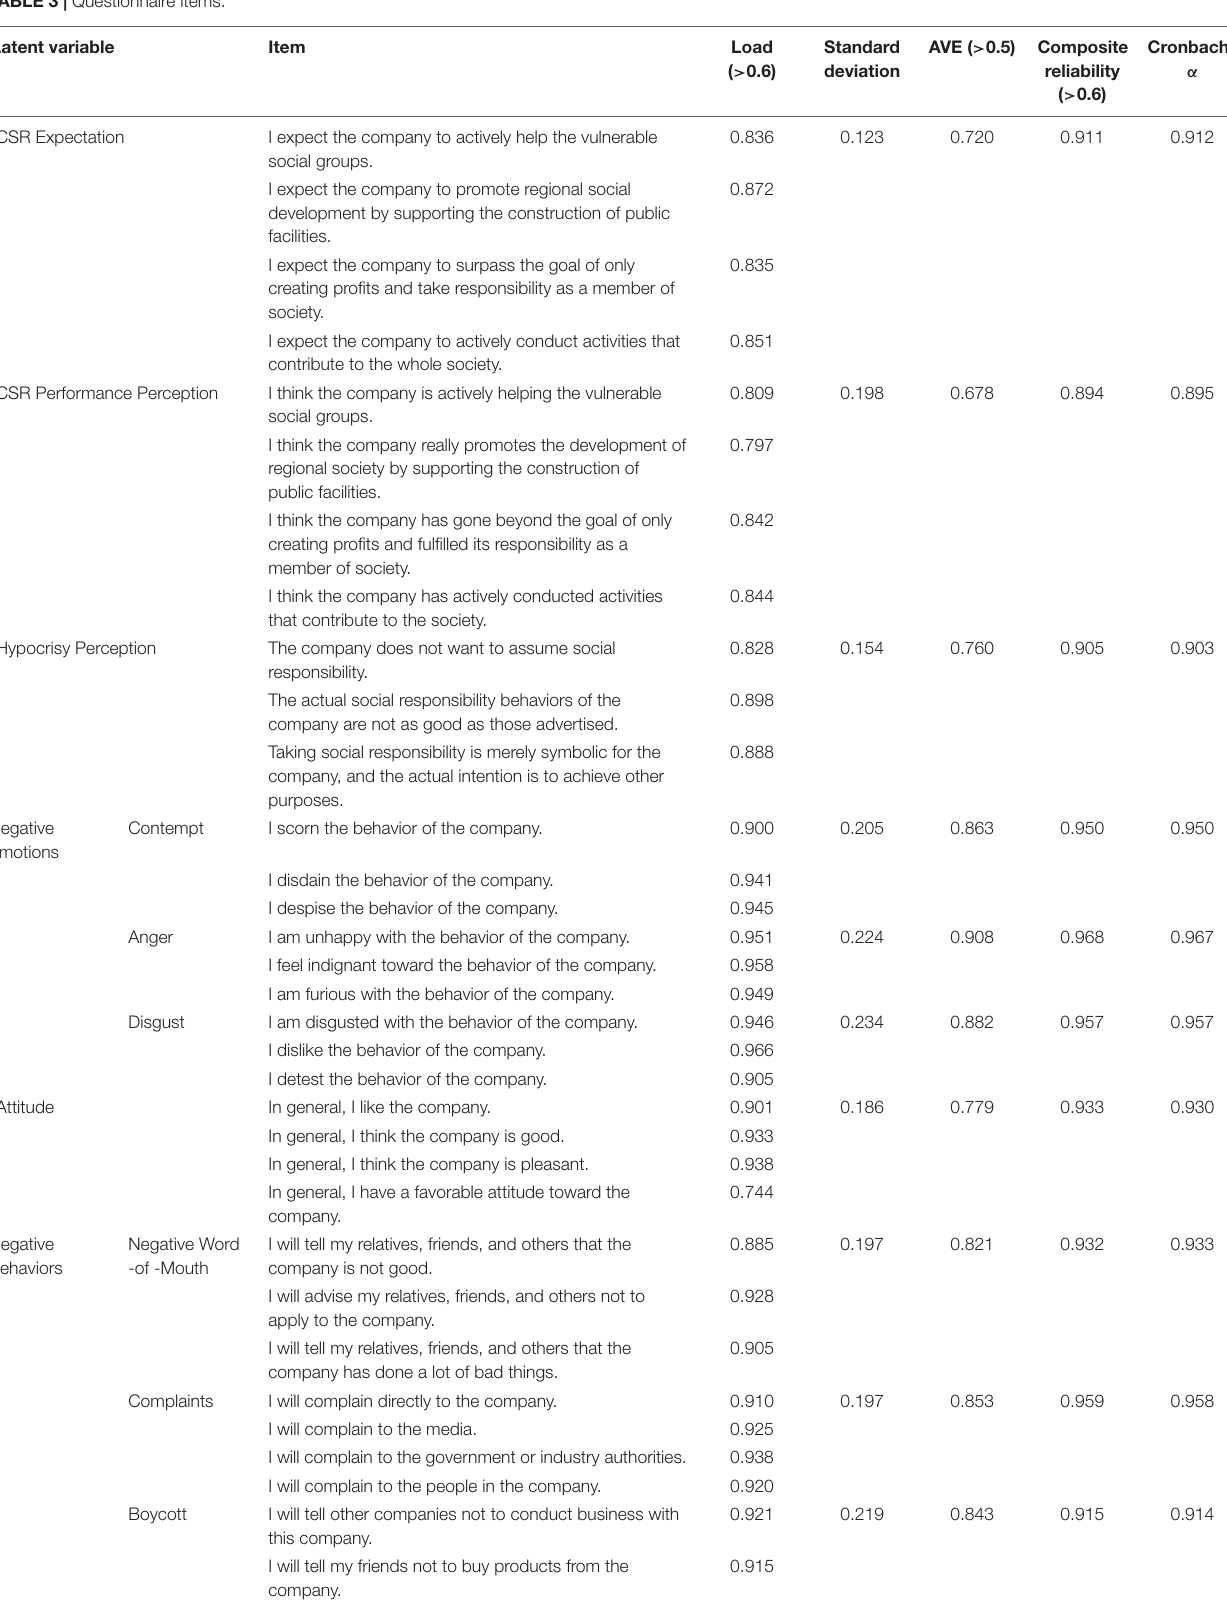
TABLE 3 | Questionnaire